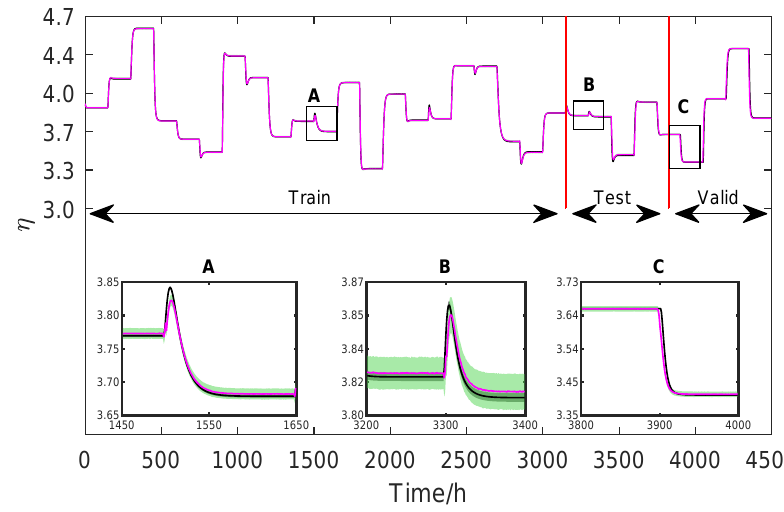
Figure 14. Training and validation data of η